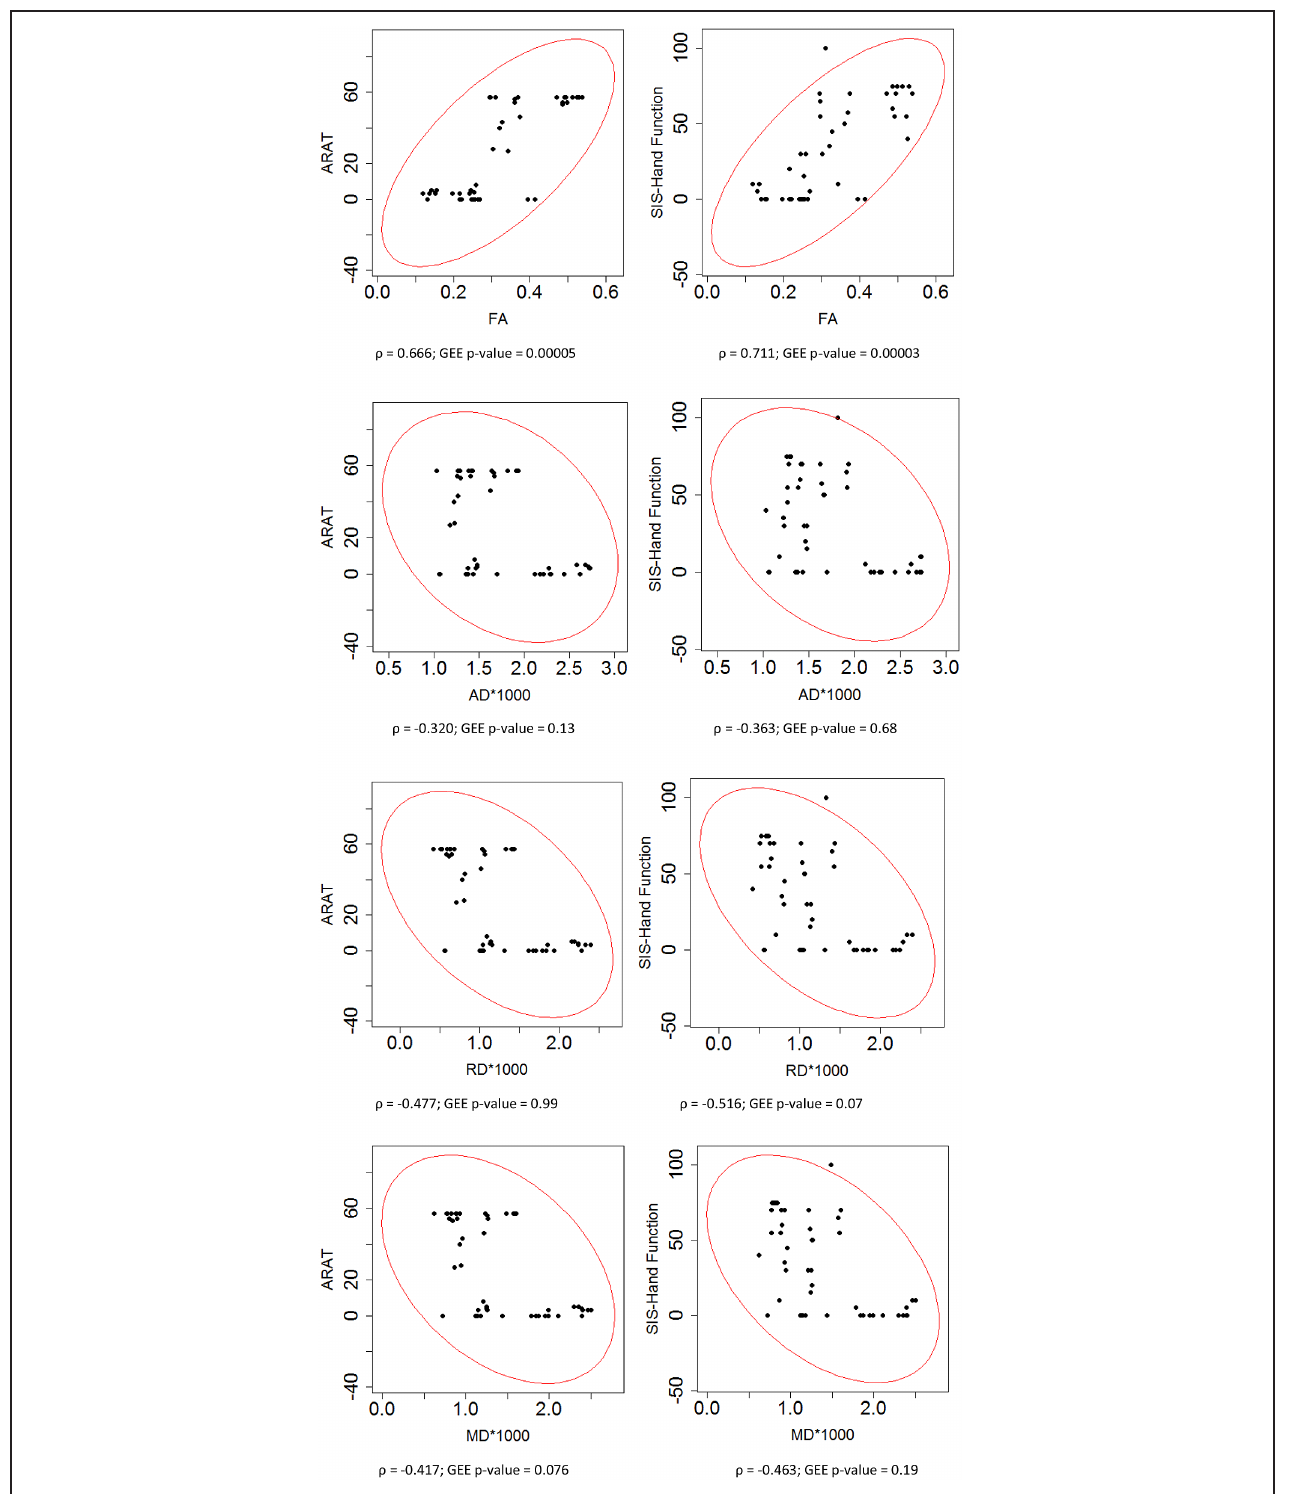
FIGURE 4 | Correlation of DTI measures and motor outcomes across time. Each DTI measure was correlated with motor outcome measures including ARAT and SIS hand function scores assessed in impaired hand. Spearman rank correlation coefficient ( ρ ) and the statistical significance of correlation (GEE p -value) are